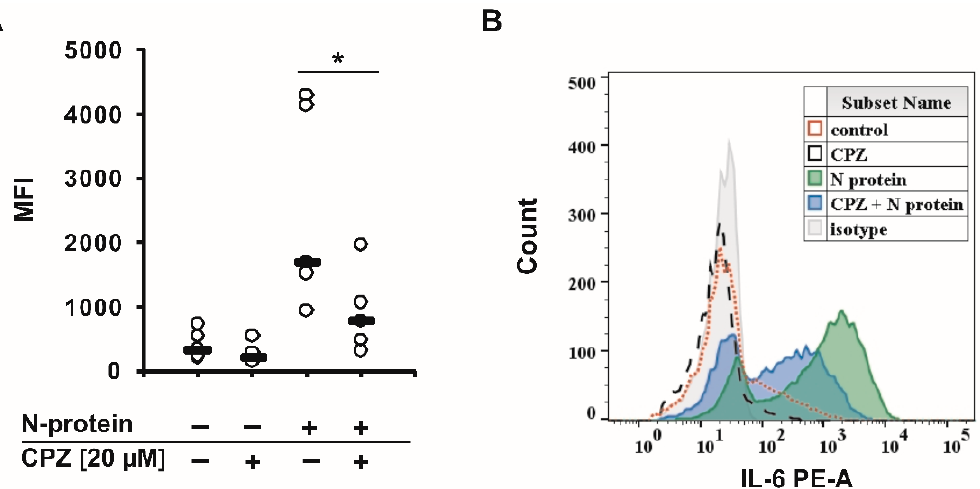
Figure 1. Structure of chlorpromazine.